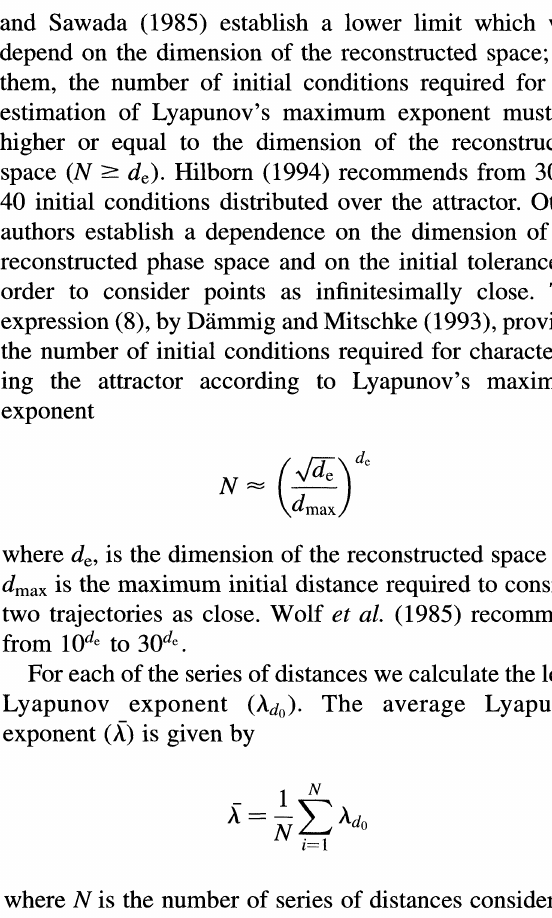
FIGURE 2 Evolution of the distances between two series generated from the logistic map for a 4 and do